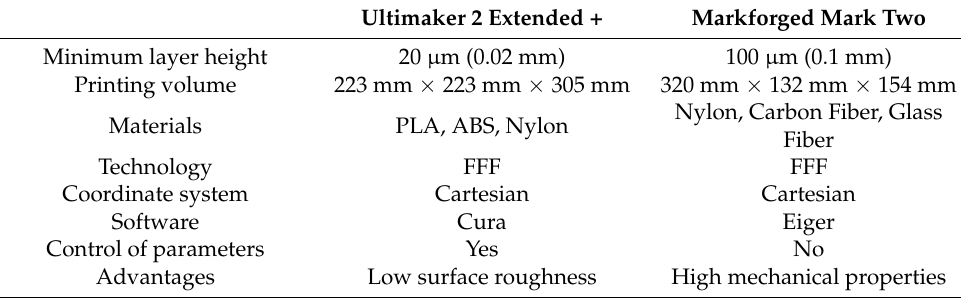
Table 2. Ultimaker and Markforged technical specifications.